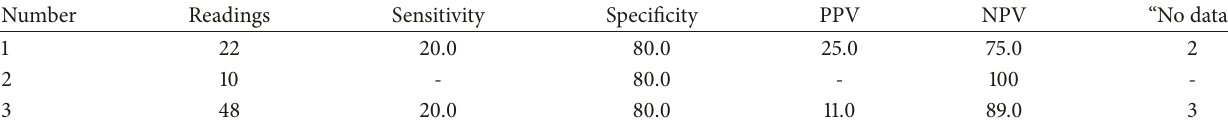
Table6:DiagnosticaccuracyofallusedPneumoScan-devices(alldatainpercent);PPV=positivepredictivevalue;NPV=negativepredictive